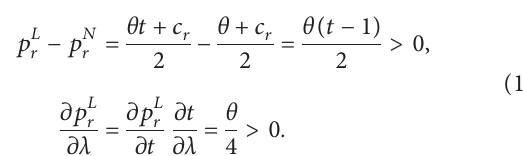
Figure 4: Impact of λ on p